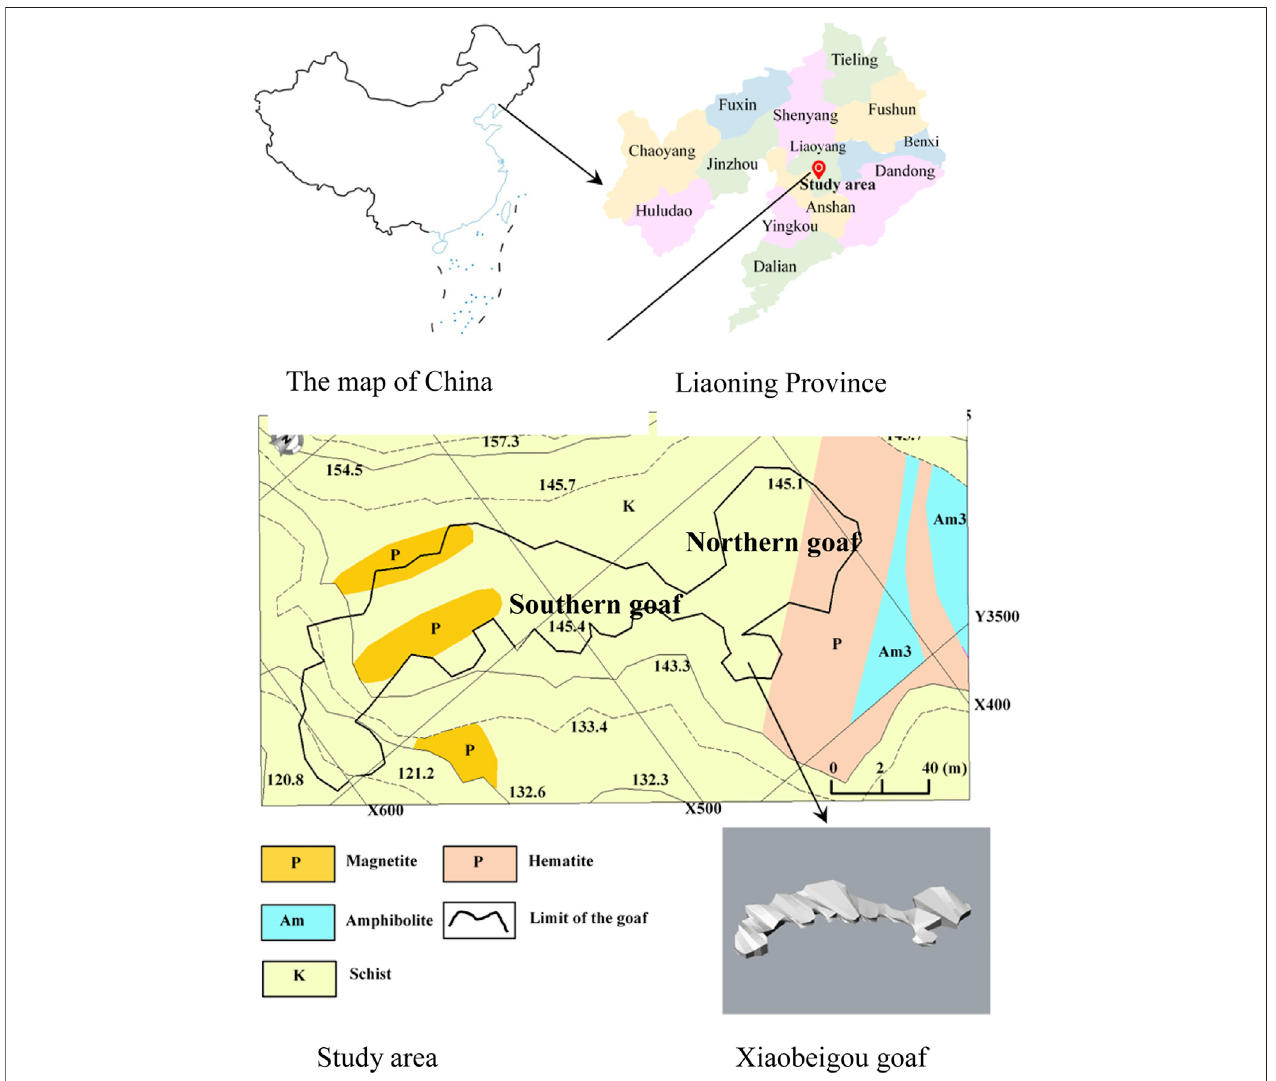
FIGURE 1 | The fi eld map of hydrostatic leveling system for the open-pit iron mine.